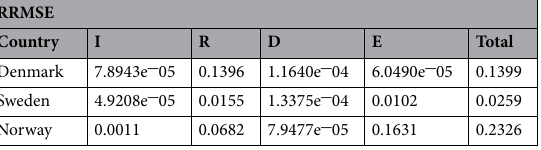
Table 1. RRMSE of the two-stage filtering method for the three Scandinavian